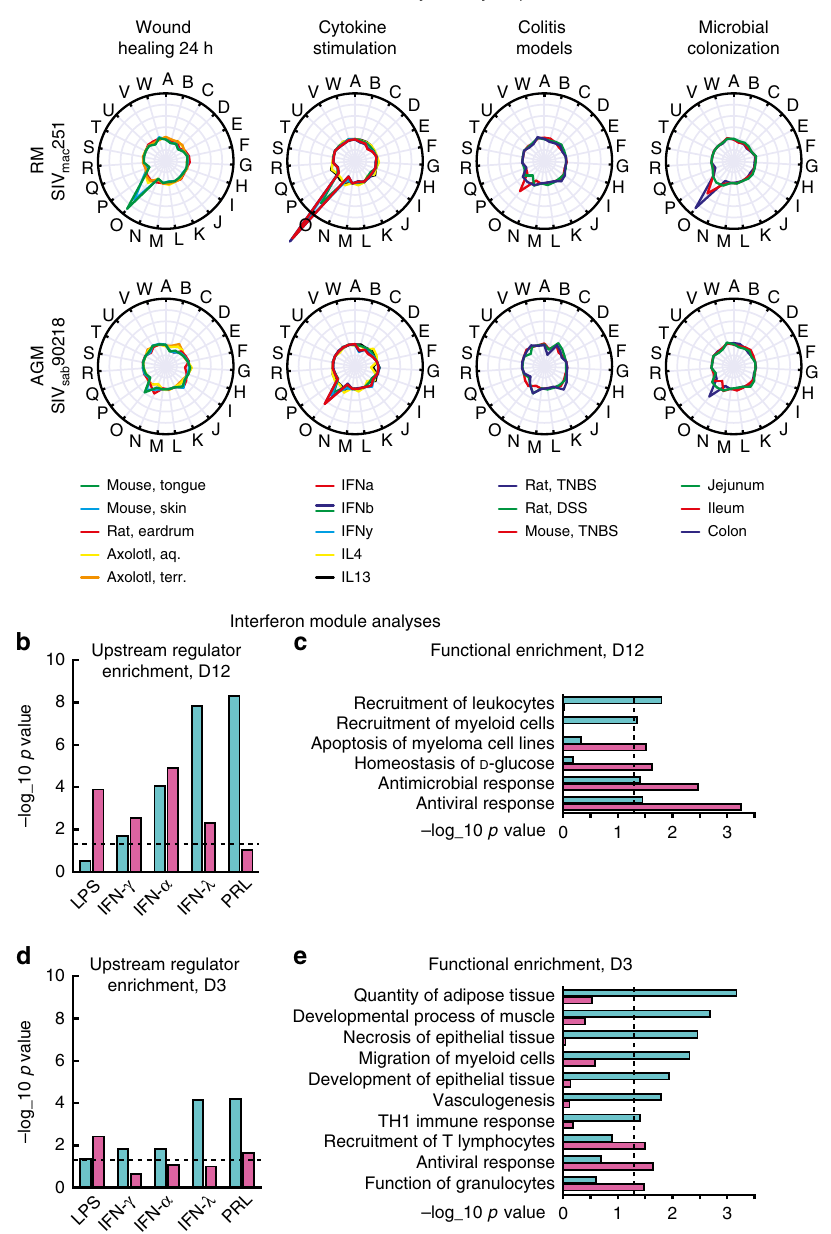
Fig. 3 Innate immunity module analysis. a Module removal analysis. Radial plots show, for each module, how much its removal reduces the global correlation (Pearson correlation coef fi cient) between reference data and acute SIV infection at D12. Each line represents a separate reference dataset. b – e Enrichment tests of DE genes from AGMs (teal) and RMs (pink), in biological functions and upstream regulator targets, compared to all genes in the Interferon Module. Enrichment tests were performed at DE genes at D3 and D12. Dashed line indicates p =